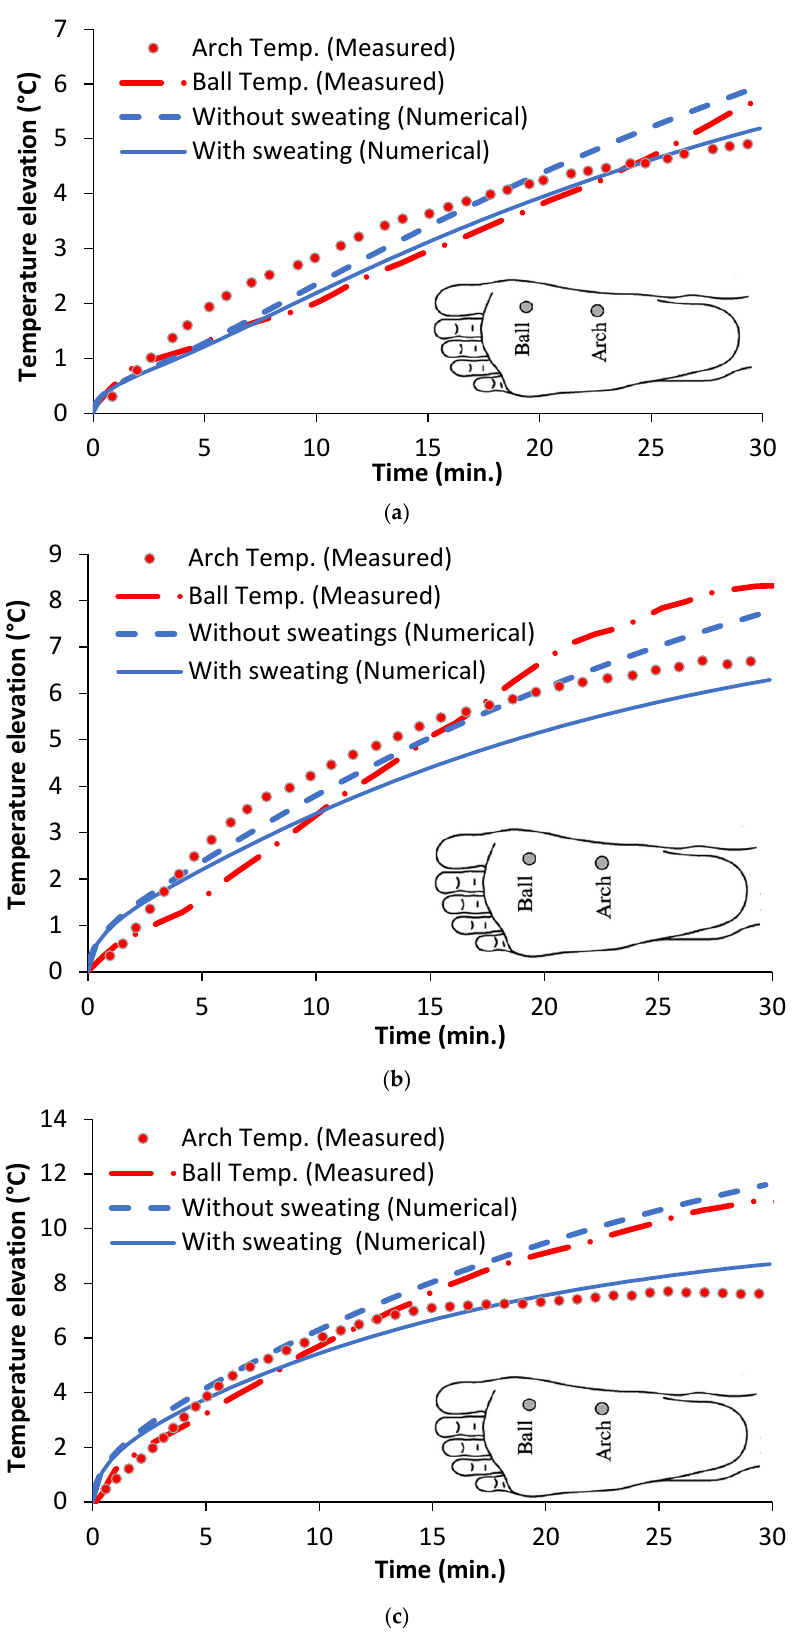
Figure 6. Comparison of foot sole temperature (numerical simulation and experimental measure- ments). ( a ) Gait speed 3 km/h; ( b ) Gait speed 6 km/h; and ( c ) Gait speed 9 km/h.